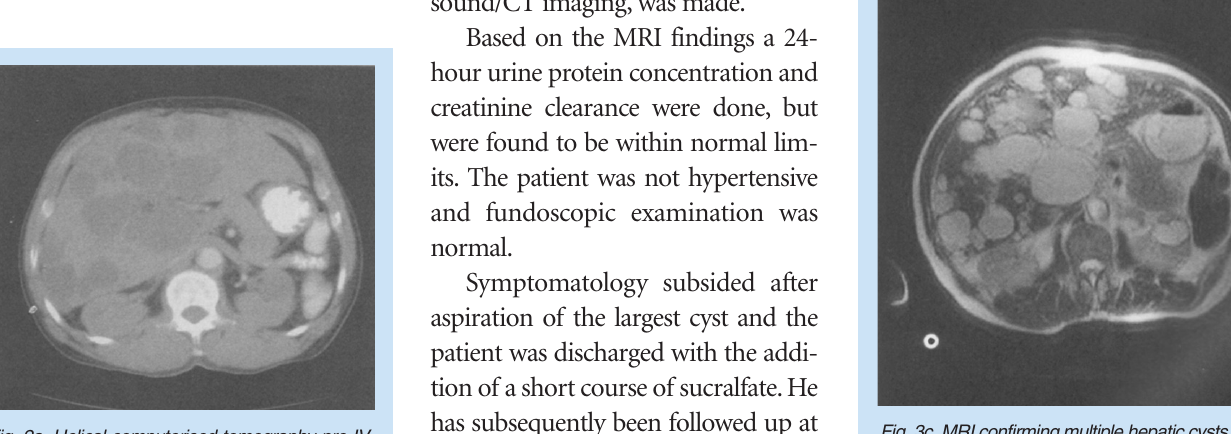
Fig. 2a. Helical computerised tomography pre IV contrast confirming hepatic and cortical cysts.